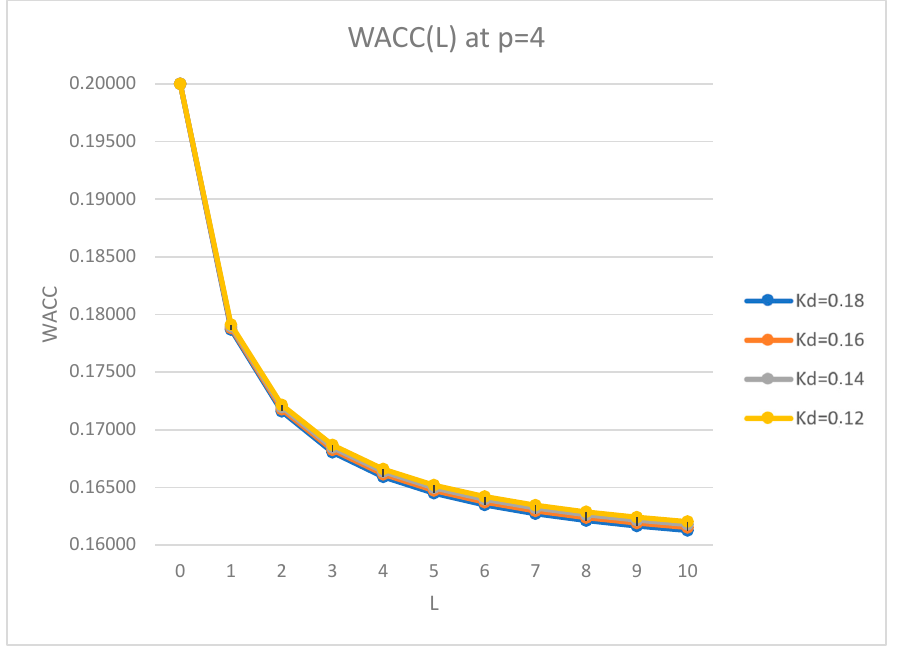
Figure 6. Dependence of the weighted average cost of capital (WACC) on leverage level L at different debt cost k d (12%; 14%; 16%; 18%) and fixed frequency of payments of tax on profit p = 4. Let us show these dependencies in a larger scale.